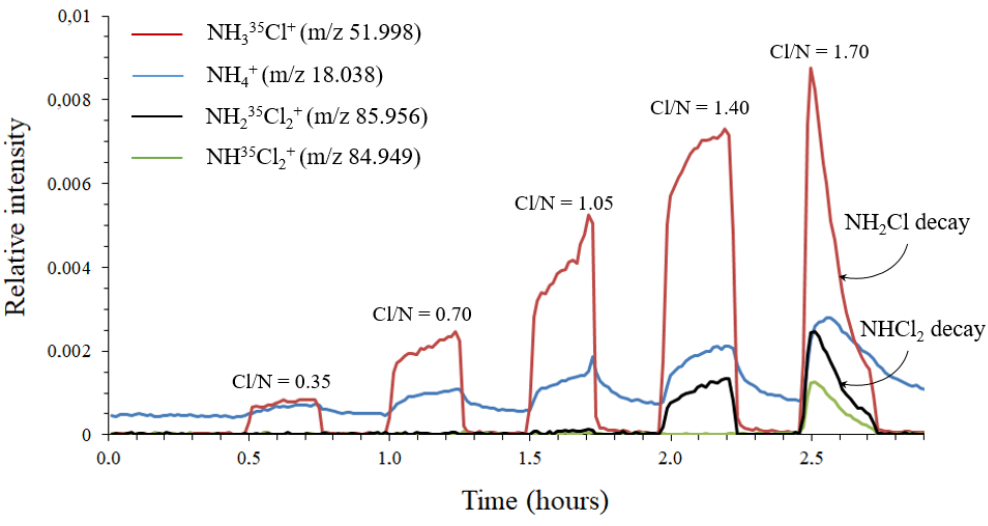
Figure 5. Stepwise chlorination of a 20 mM NH 4 Cl solution with di ff erent molar Cl:N ratios in headspace mode.